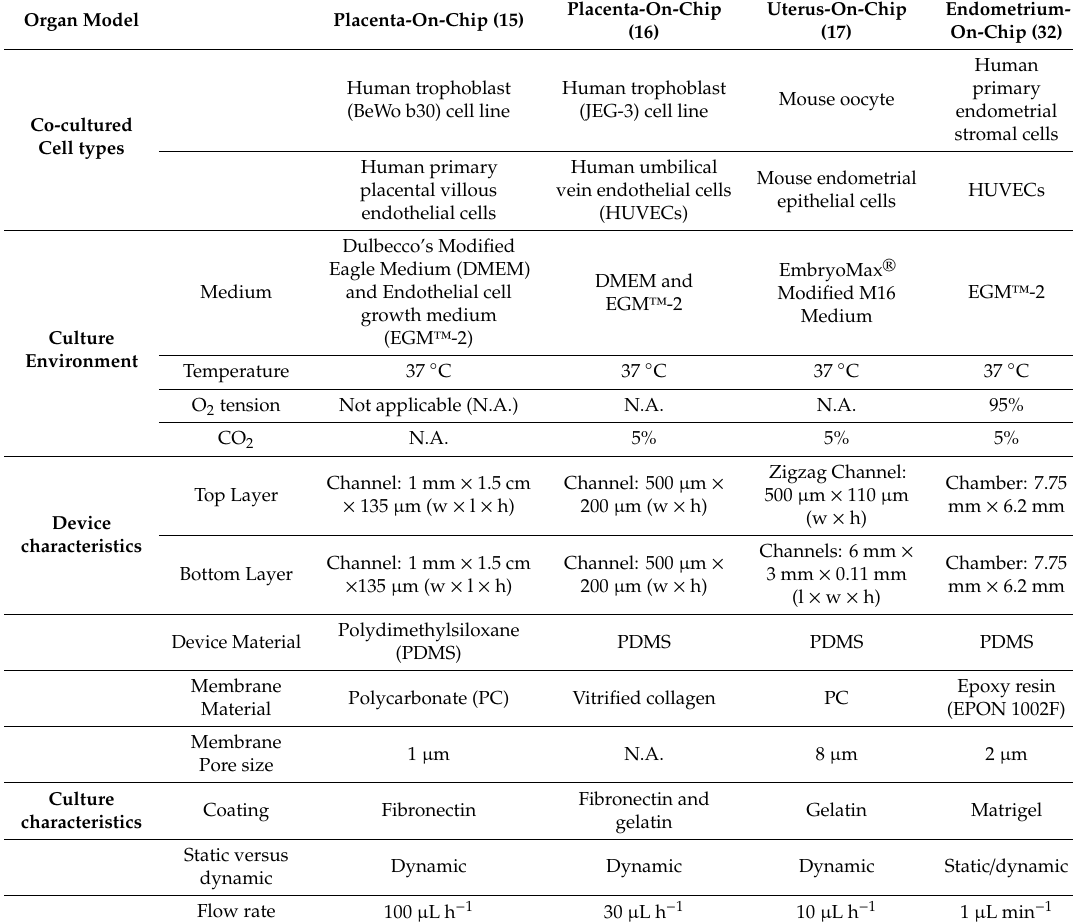
Table 1. Examples of Organs-on-chip models of the female reproductive